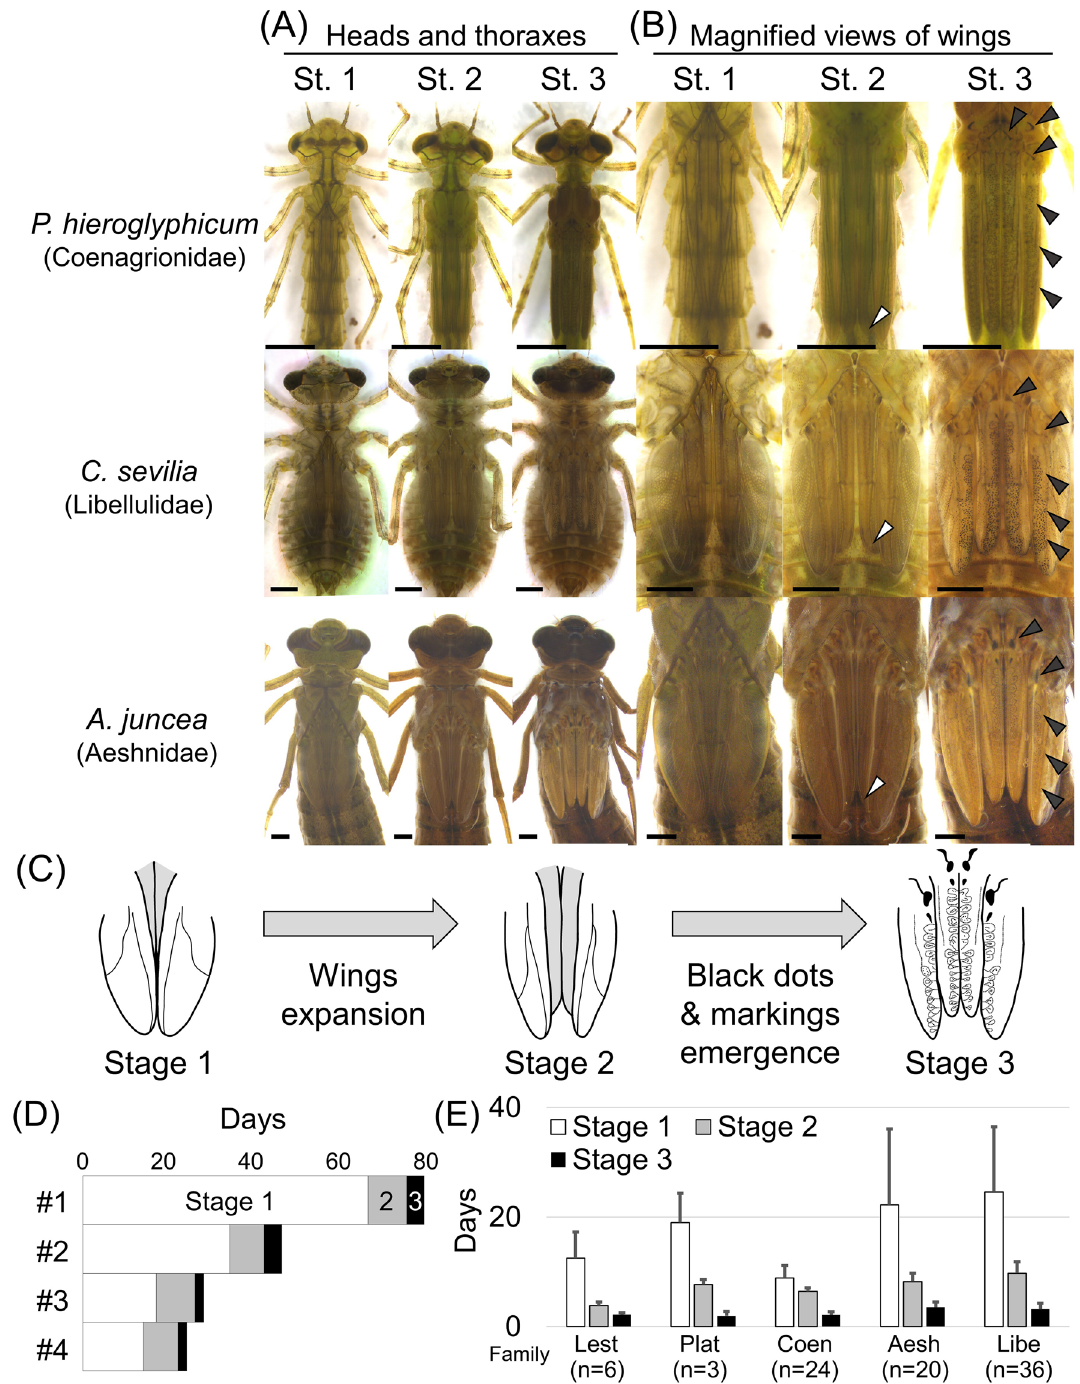
Figure 3. Summary of three developmental stages commonly observed in F−0 instar larvae among diverse Odonata species. ( A ) Dorsal views of heads, thoraces, and wings. ( B ) Magnified views of wing sheaths. White arrowheads indicate the dorsal tips of forewings (defining the onset of stage 2). Black arrowheads indicate the black dots and markings on the wing sheaths (defining the onset of stage 3). All scale bars show 2 mm. All the photos were taken on the first day of each stage. ( C ) Schematic diagrams of three developmental stages. ( D ) Durations of stages 1, 2 and 3 of four individuals of Aeshna crenata (Aeshnidae), highlighting varied lengths of stage 1 compared with relatively short and constant lengths of stages 2 and 3 (also see Table S1). ( E ) Durations of stages 1, 2 and 3 of F−0 instar larvae representing different Odonata families. Error bars show standard deviations. Lest Lestidae, Plat Platycnemididae, Coen Coenagrionidae, Aesh Aeshnidae, Libe